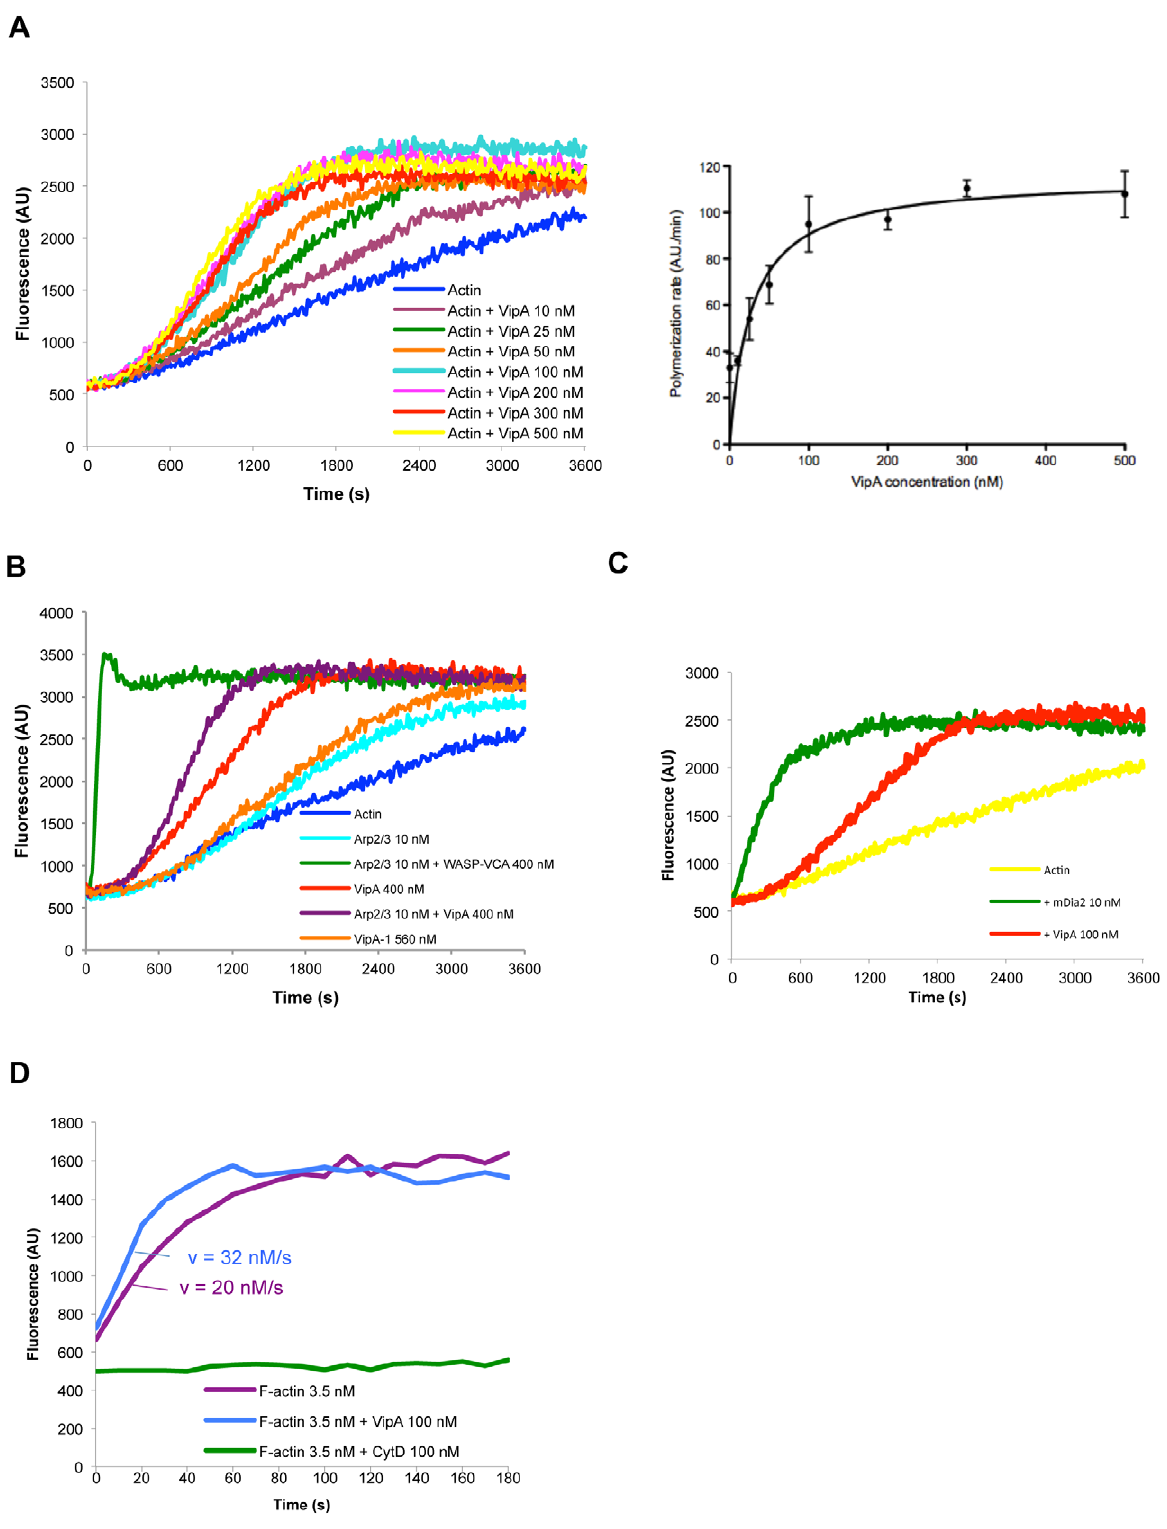
Figure 3. Invitro actin polymerization assays. Samples contained 2 m M monomeric actin (10% Pyrene-actin) and fluorescence (expressed in Arbitrary Units, AU) was measured over time after initiation of polymerization. A. The displayed concentrations of His 6 -VipA were added to the samples and polymerization initiated. The graph on the right is a plot of the average and standard deviation for the rates of actin polymerization for each His 6 -VipA concentration. Velocities were determined for the interval 600–1200 s using the results of two independent experiments. B and C. Actin samples contained 10 nM Arp2/3 complex, 400 nM WASP-VCA (Cytoskeleton), 400 nM His 6 -VipA, 560 nM His 6 -VipA-1 and 10 nM of mDia2 where indicated. D. Elongation of filaments was carried out using phalloidin-stabilized actin seeds and 1 m M of G-actin (10% Py-labeled), in the